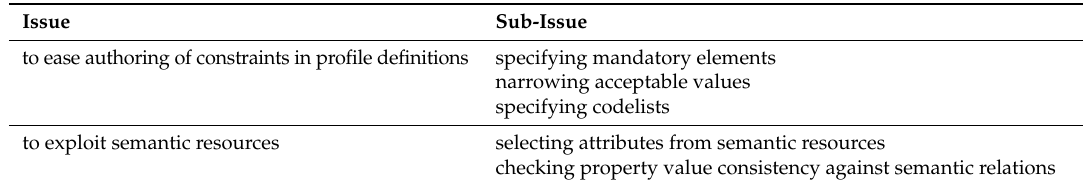
Table 1. Summary of the issues addressed in this